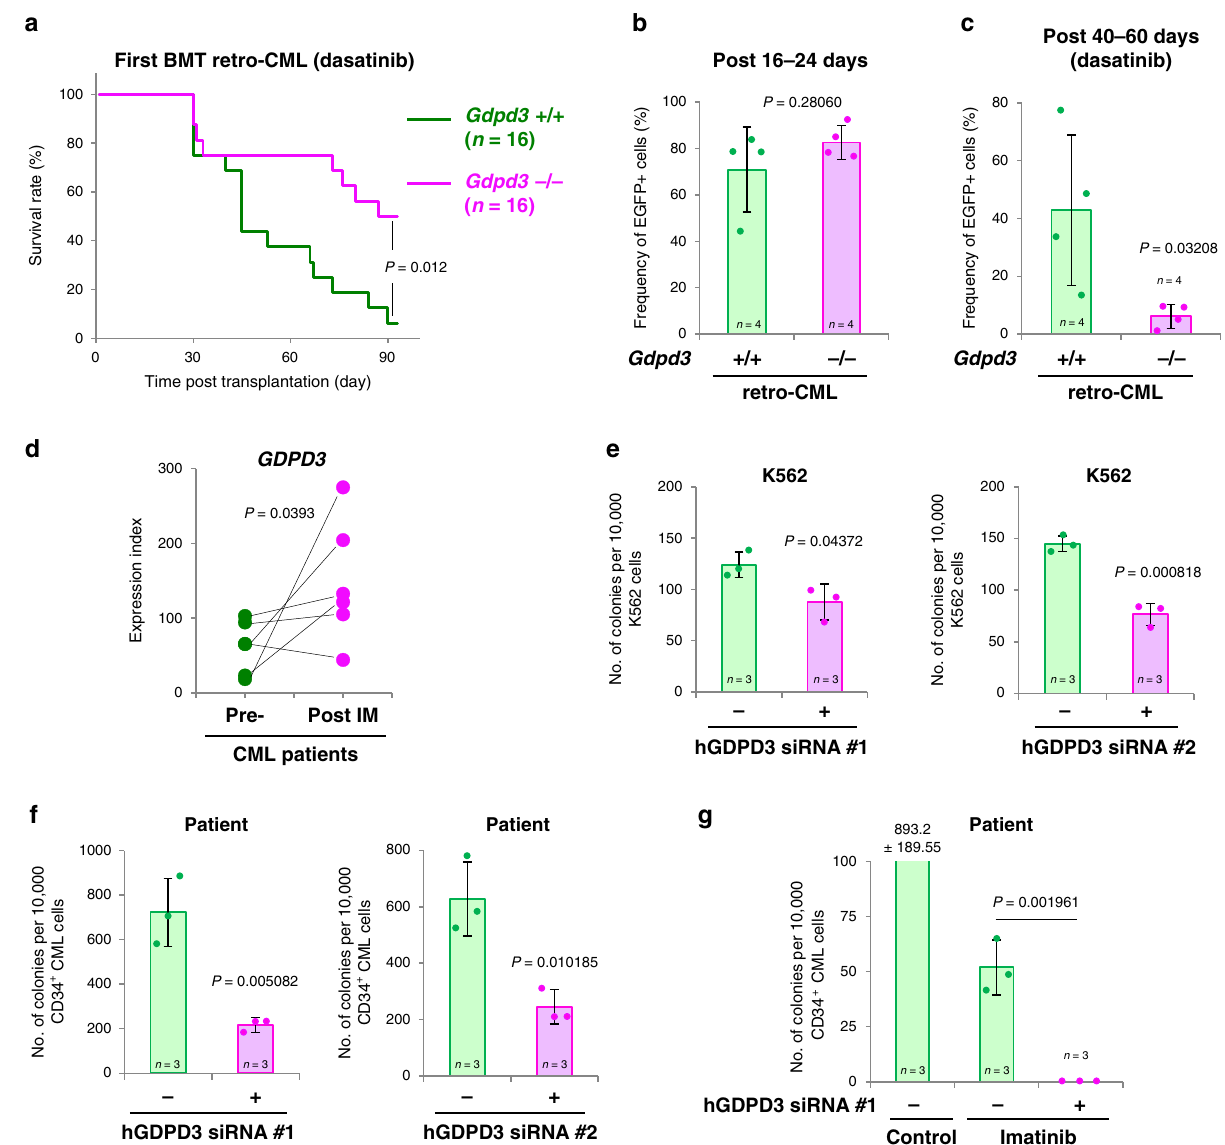
Fig. 6 Gdpd3 is implicated in TKI-resistance in mouse and human CML stem cells. a Survival rates of retro-CML-affected mice in a primary